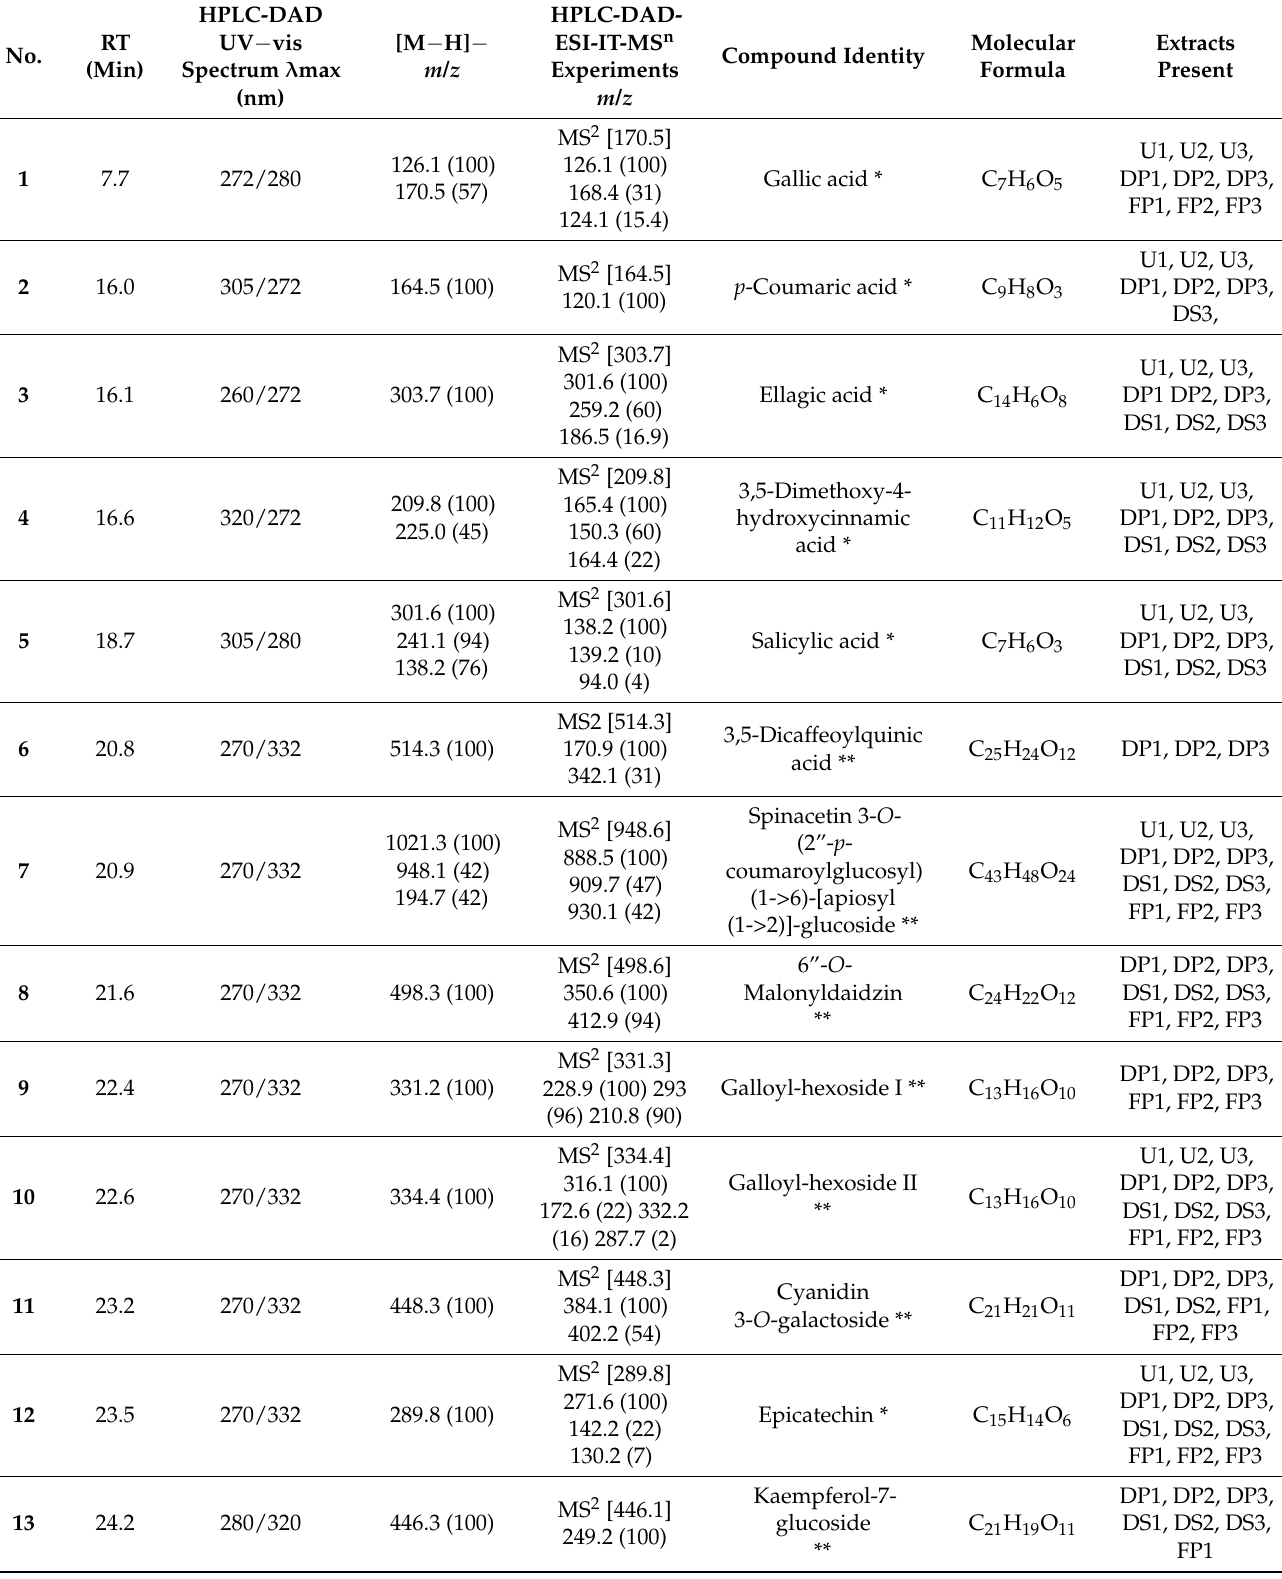
Table 3. Identified compounds in treated persimmon fiber fractions by HPLC-DAD-ESI-IT- MS n .